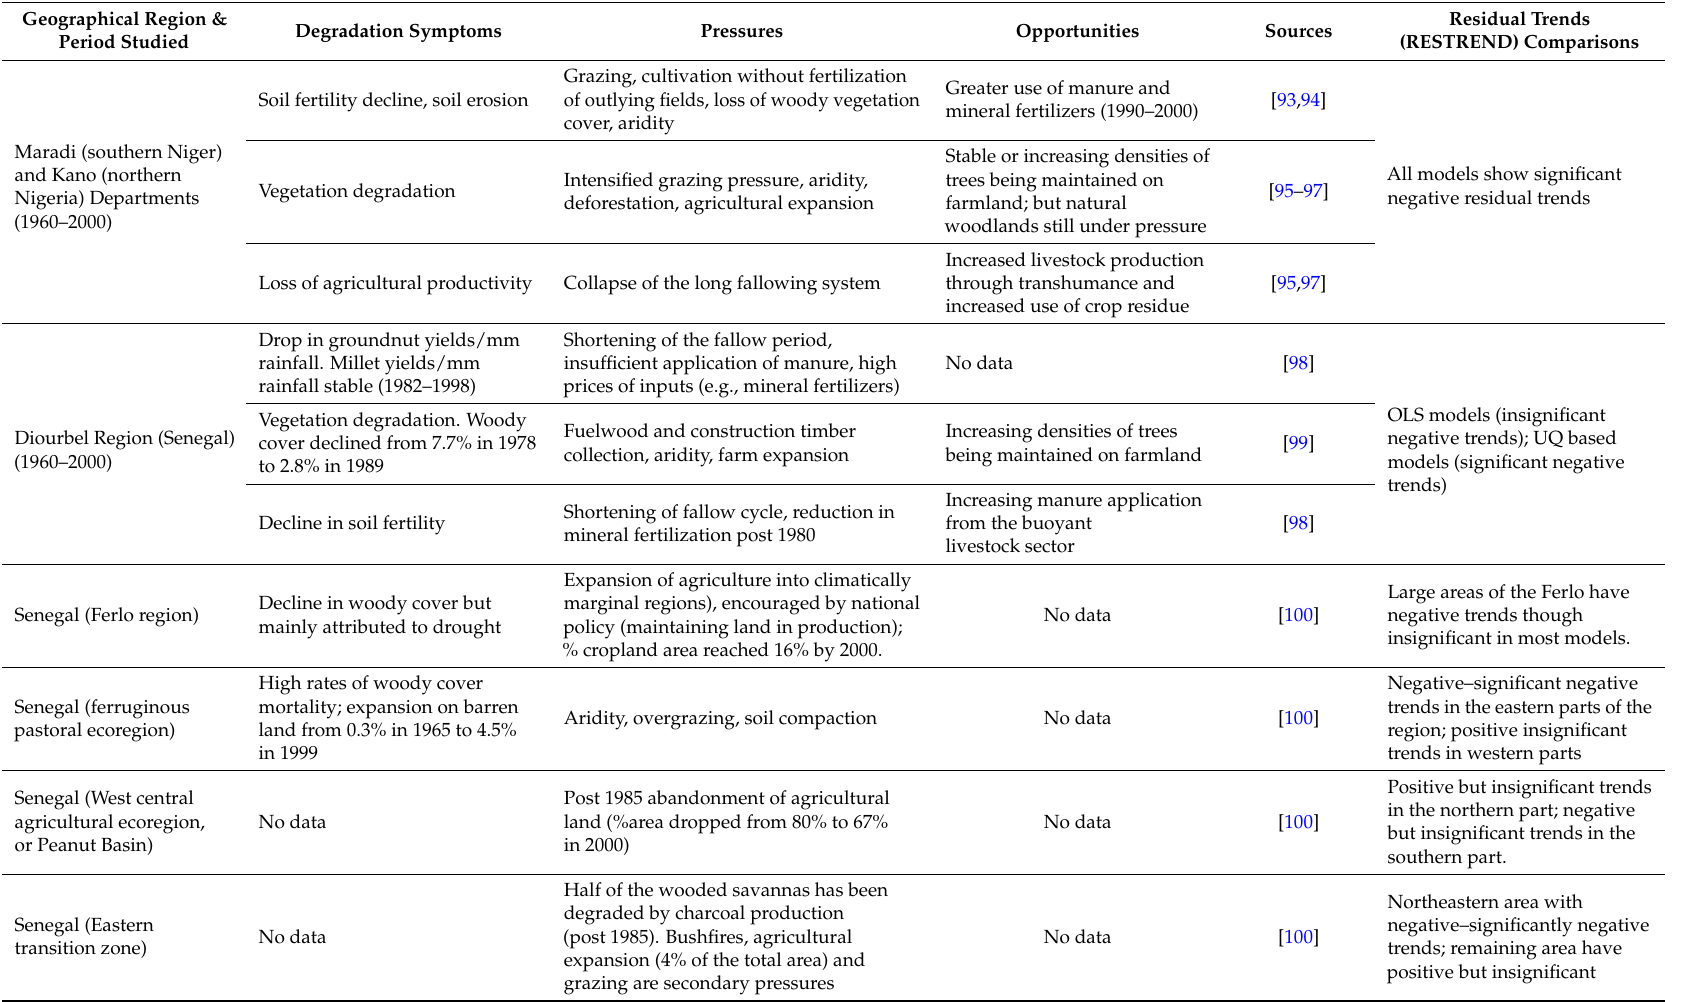
Table 7. Comparisons between RESTREND results and published literature on the status of land degradation and land use in the